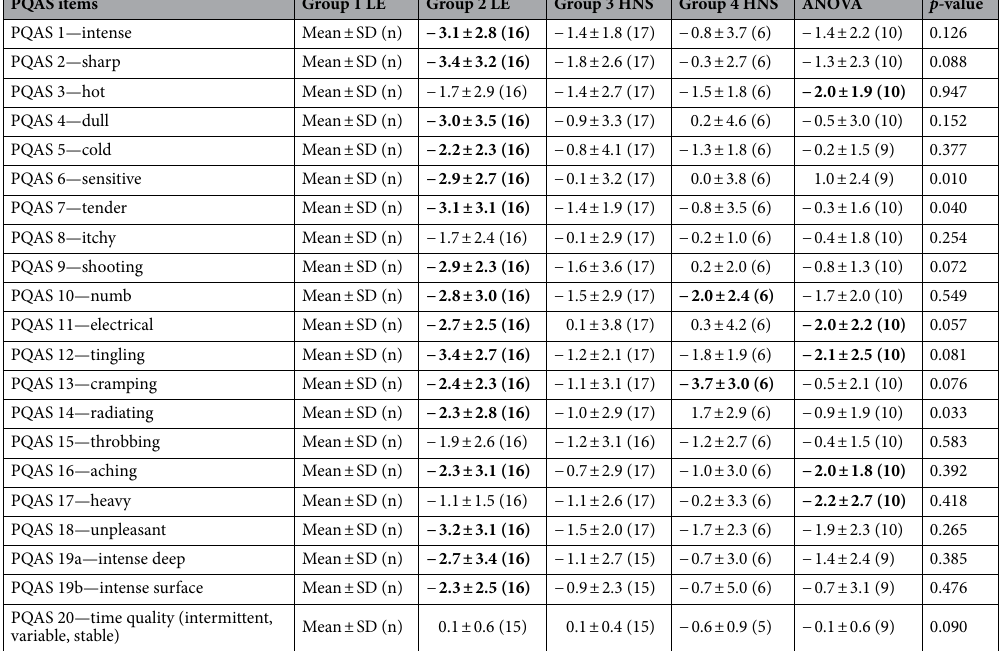
Table 5. Individual PQAS changes scores [End-of-Study (week 10) minus Baseline]. Group 1: intervention (lower extremity, LE) massage 3 times per week for 4 weeks. Group 2: intervention (lower extremity, LE) massage 2 times per week for 6 weeks. Group 3: control (head/neck/shoulder, HNS) massage 3 times per week for 4 weeks. Group 4: control (head/neck/shoulder, HNS) massage 2 times per week for 6 weeks. Bold represents > 2-point change